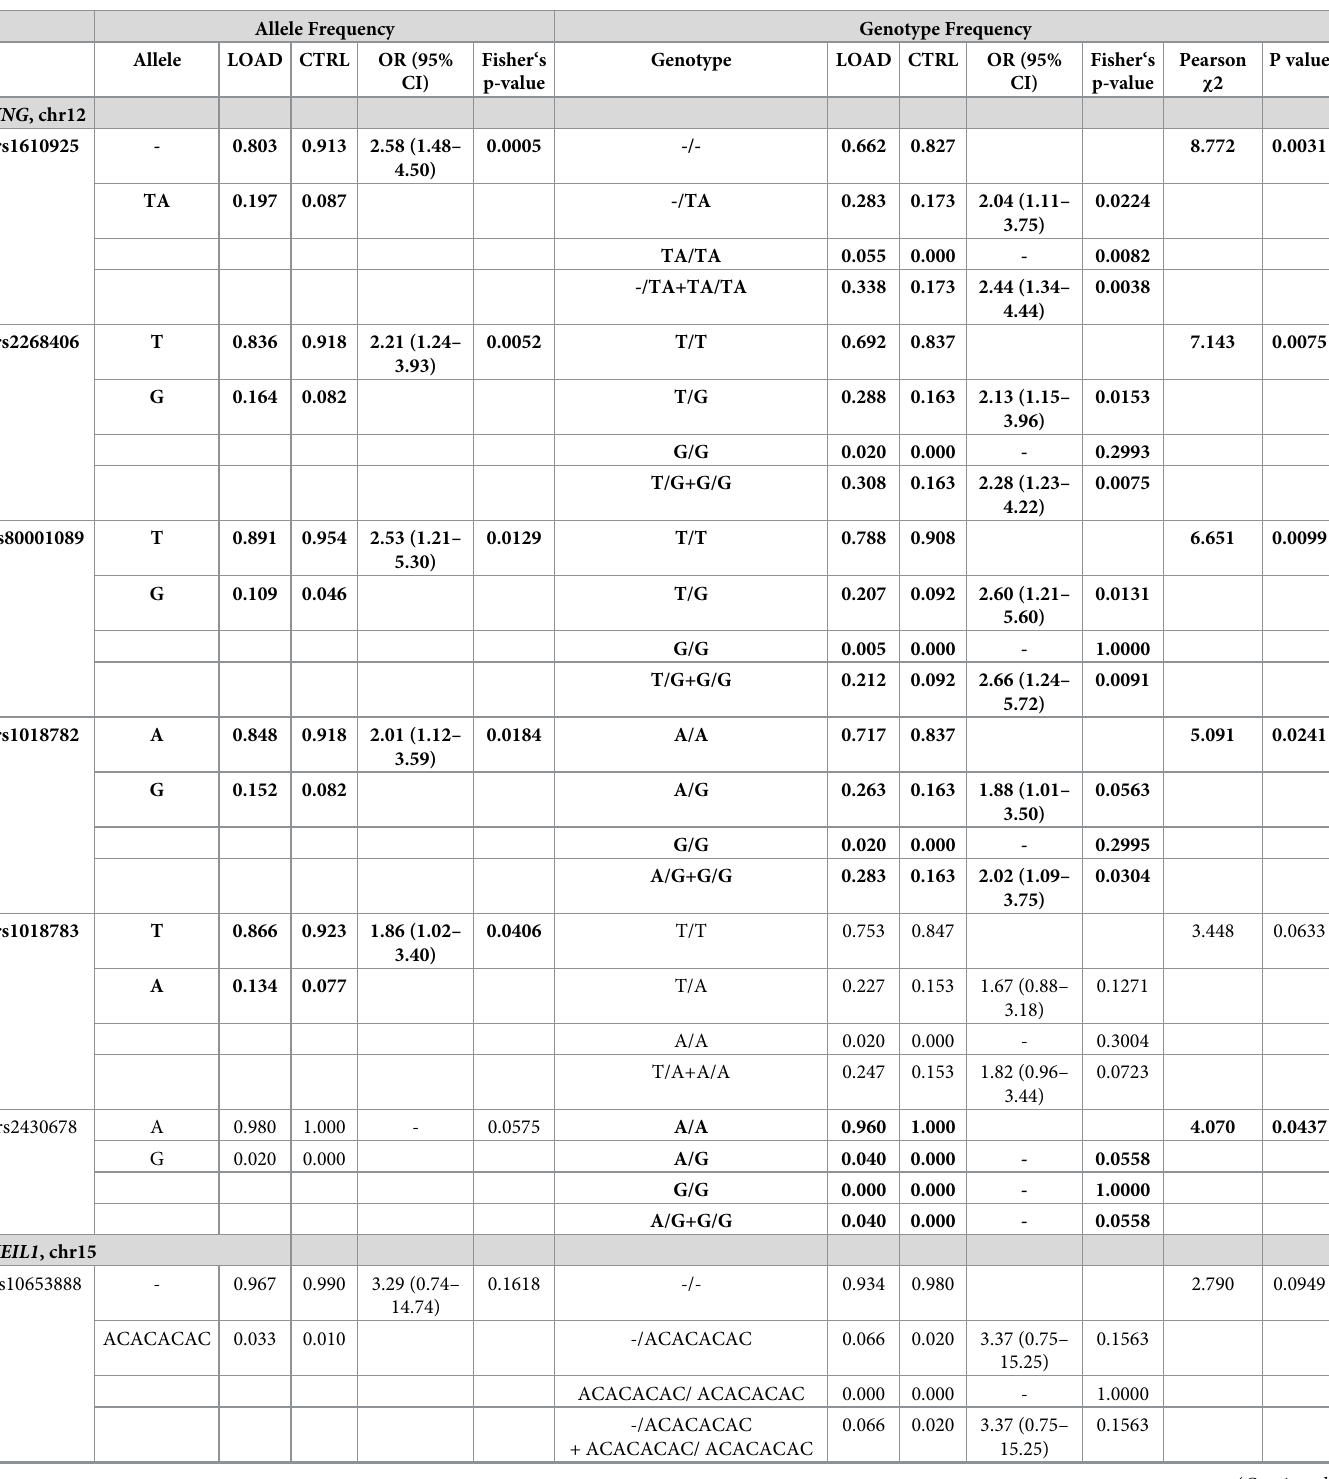
Table 3. Allele and genotype frequencies of UNG , POL β , NEIL1 and APOE in peripheral blood samples of LOAD patients and age-matched cognitively normal